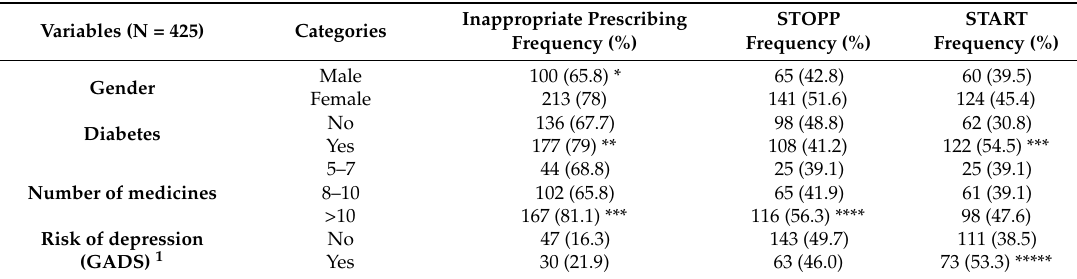
Table 2. Prevalence of STOPP-START